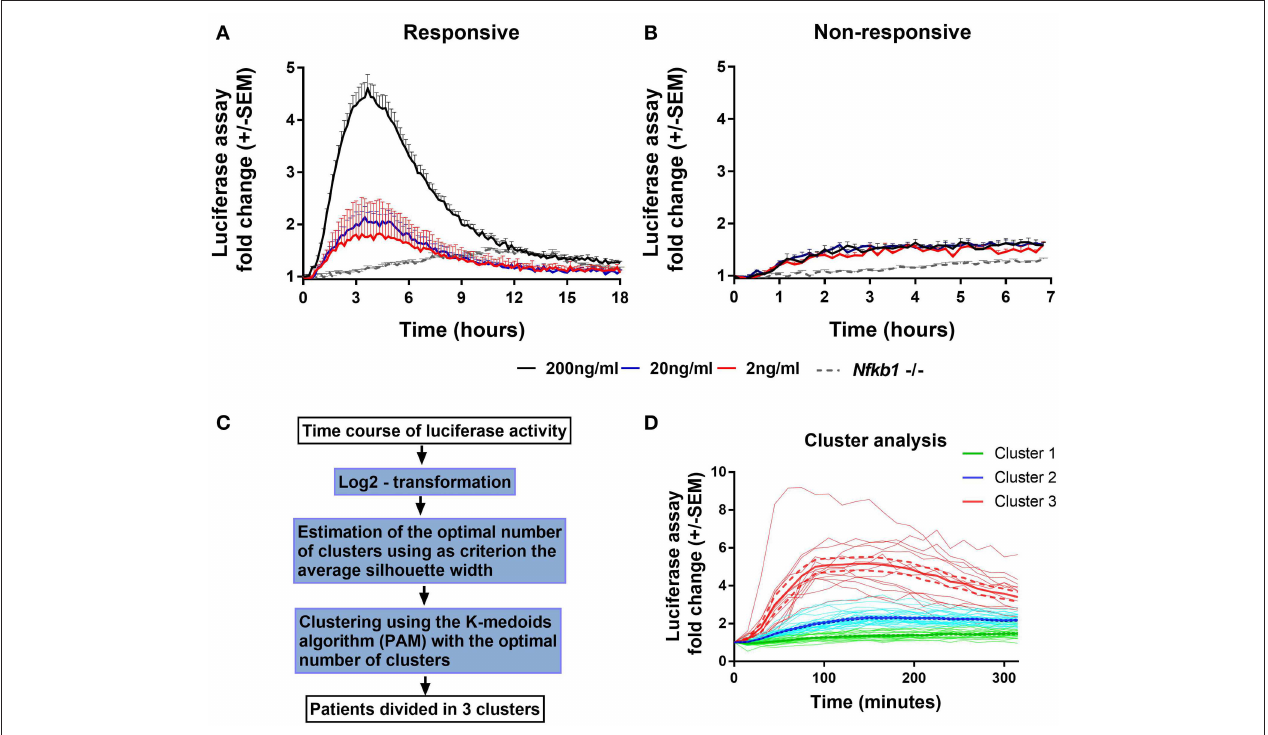
FIGURE 1 | Endogenous NF- κ B-regulated luciferase activity in lipopolysaccharide-stimulated PBMDMs. Graphs of κ B-NLSluc luciferase activity measured over time (0–18h) from differentiated human PBMDMs of two representative patients that were either (A) responsive or (B) non-responsive to stimulation with increasing doses of lipopolysaccharide (LPS); 2ng/mL (red line), 20ng/mL (blue line), and 200ng/mL (black line); n = 5 vials PBMDM cultures for each patient. Nfkb1 − / − murine BMDMs ( N = 3 mice, n = 2 replicates) stimulated with 200ng/mL LPS were used as a negative luciferase activity control (gray dotted line). (C) Flow chart describing the steps that were followed for the clustering analysis (PAM = partitioning around medoids). (D) LPS-stimulated PBMDMs could assigned to one of three clusters based on log 2 fold change in the luciferase activity profile using K-medoids algorithm. Bold lines show mean values, Dashed lines show ± standard error of the mean (SEM), and faint lines show individual